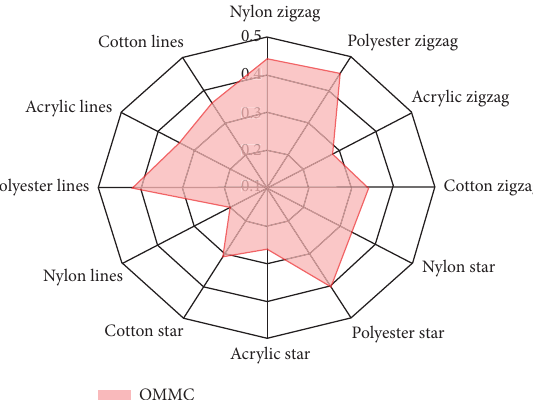
Figure 24: OMMC of auxetic